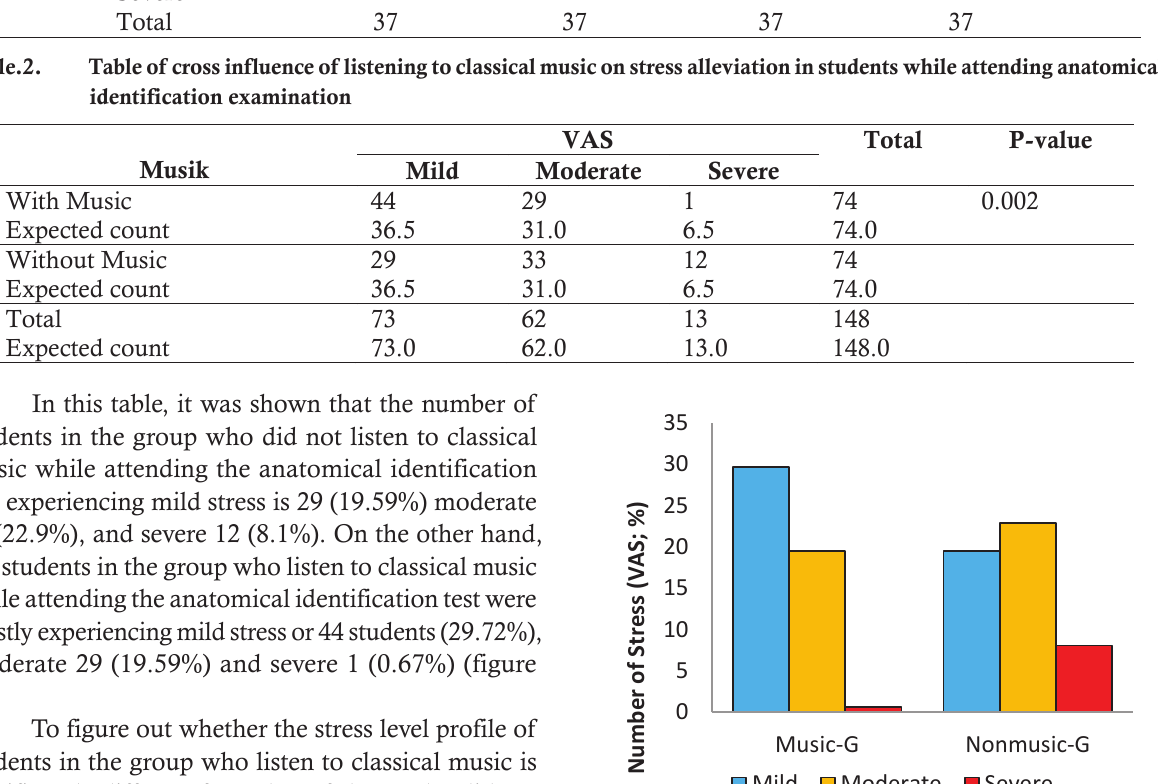
Figure 1. Student’s Stress Profile